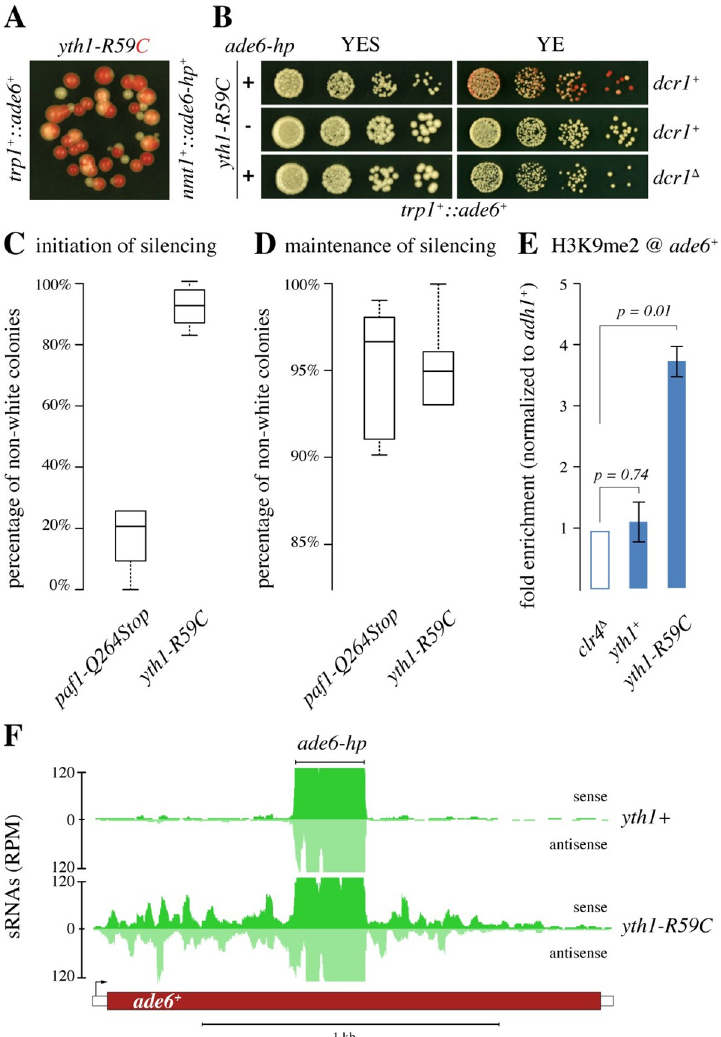
Fig 2. Arginine to cysteine substitution in Yth1 enables small-RNA-directed heterochromatin assembly. (A and B) Silencing assays showing the ade6 + silencing phenotype in yth1-R59C mutant cells. Silencing in individual colonies is typically variegating (A), which is lost in cells lacking either Dicer ( dcr1 Δ ) or the ade6 RNA hairpin ( ade6-hp ) (B). (C and D) Comparison of initiation (C) and maintenance (D) of ade6 + silencing in paf1-Q264Stop and yth1-R59C cells ( trp1 + :: ade6 + , nmt1 + :: ade6-hp + ). Multiple individual originator colonies (white or red in C or D, respectively) were spread to single cell density on YE plates to assess initiation/maintenance of the silencing phenotype: n = 6 for paf1-Q264Stop white originator (C, total counted number of colonies = 2547), n = 6 for paf1-Q264Stop red originator (D, total counted number of colonies = 3016), n = 12 for yth1-R59C white originator (C, total counted number of colonies = 4063), n = 9 for yth1-R59C red originator (D, total counted number of colonies = 9468). (E) ChIP analysis of H3K9me2 in the strains indicated ( trp1 + :: ade6 + , nmt1 + :: ade6-hp + ). Fold enrichments were normalized to adh1 + and are shown relative to background levels measured in clr4 Δ cells. Error bars indicate standard deviation, n = 3 independent biological replicates, p-values were calculated with a two-tailed Student’s t-test. The ade6 + primer pairs do not discriminate between endogenous ade6-704 and trp1 + :: ade6 + genes. (F) Small RNA sequencing was performed with yth1 + and yth1-R59C cells to assess secondary ade6 + siRNA production. Read counts were normalized to library size. The part of ade6 + that is complementary to the primary siRNAs encoded by the ade6-hp is